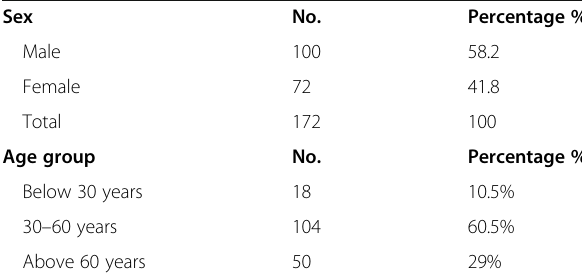
Table 1 Age and sex distribution of patients with COVID-19 pulmonary infection